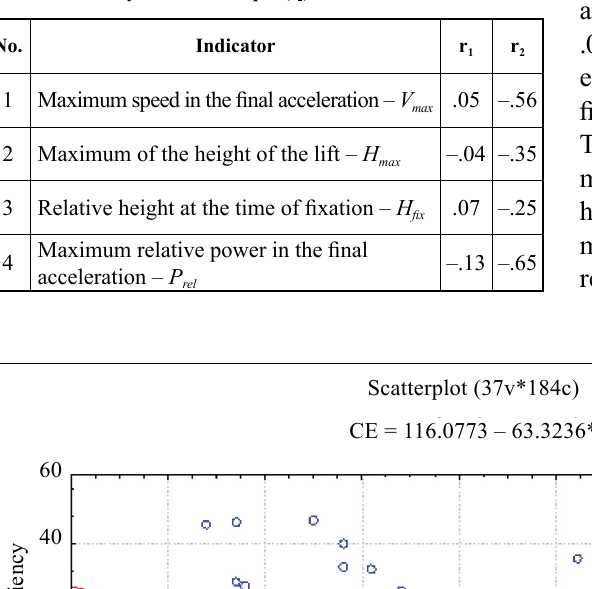
Table 2. Correlation coefficients of some parameters of movement of the bar with the result in the snatch ( r 1 ) and the coefficient of the realized efficiency of the technique ( r 2 )